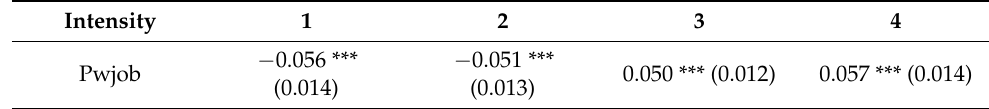
Table 3. Marginal effect of the key variables.